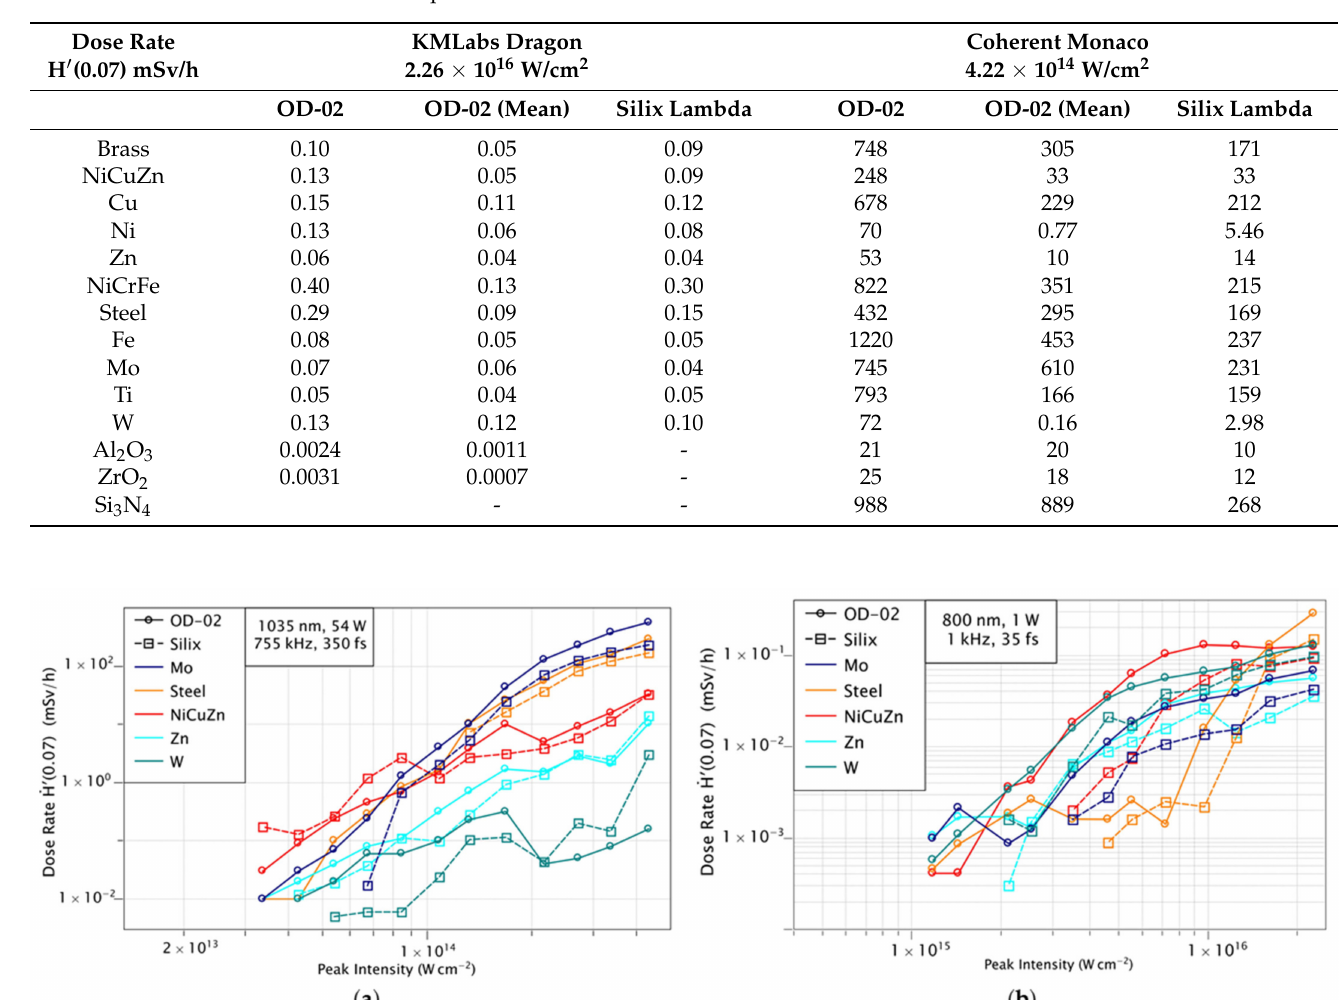
Table 3. Comparison of the measured dose rates from the Silix and the OD-02.